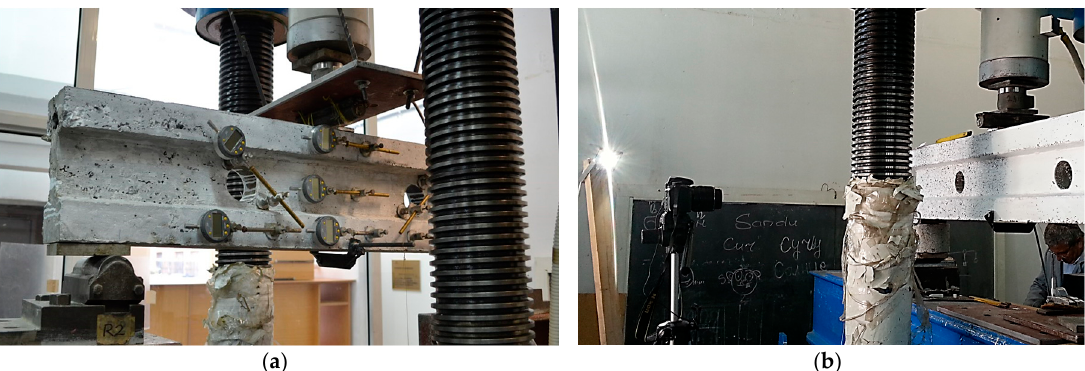
Figure 3. Equipment for beams. ( a ) The set-up of the mechanical gauges and displacement transducer. ( b ) The equipment required to apply the optical method (DIC).